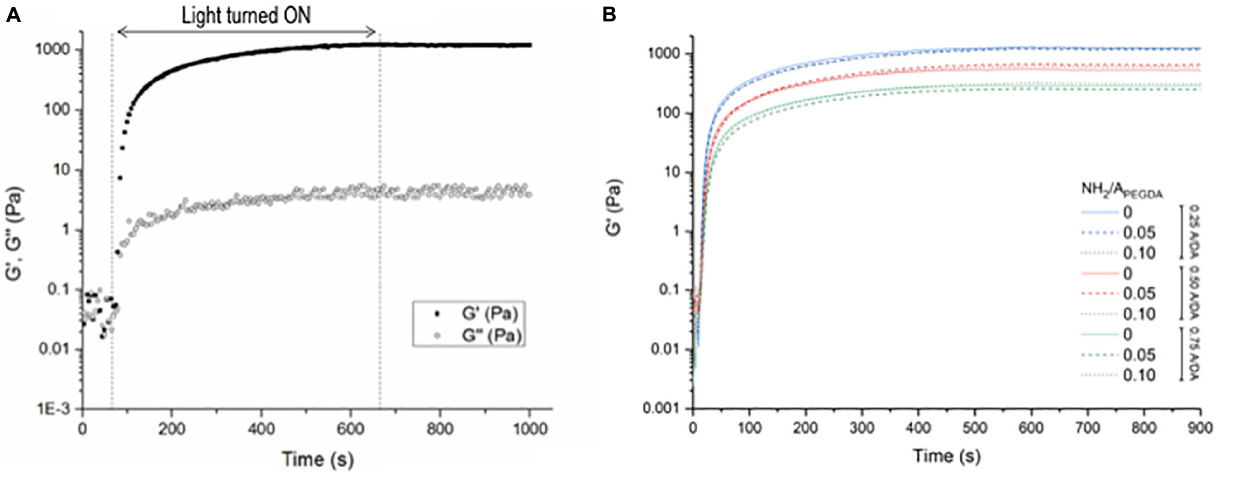
FIGURE 1 | Shear rheology measurements during hydrogel photo-crosslinking. Samples were irradiated for 600 s (460 nm, 140 mW/cm 2 ); measurements were performed up to 900 s. (A) Storage ( G (cid:48) ) and loss ( G (cid:48)(cid:48) ) shear moduli measured for the 0.50–0.10 A/DA-NH 2 /A PEGDA hydrogel formulation as a function of time. The irradiation period is displayed between the dashed lines. Samples were monitored for additional 300 s after irradiation. (B) Variation of G (cid:48) during and after light exposure for all investigated hydrogel formulations: 0.25 A/DA ratio (blue), 0.50 A/DA ratio (red) and 0.75 A/DA ratio (green); no hydrogel amino content (solid line), hydrogel amino contend NH 2 /A PEGDA molar ratio = 0.05 (dashed line) and hydrogel amino contend NH 2 /A PEGDA molar ratio = 0.10 (dotted line). Each curve is the average of measurements performed on n = 3 independent samples per formulation. Time 0 is here defined as the instant at which the light was switched